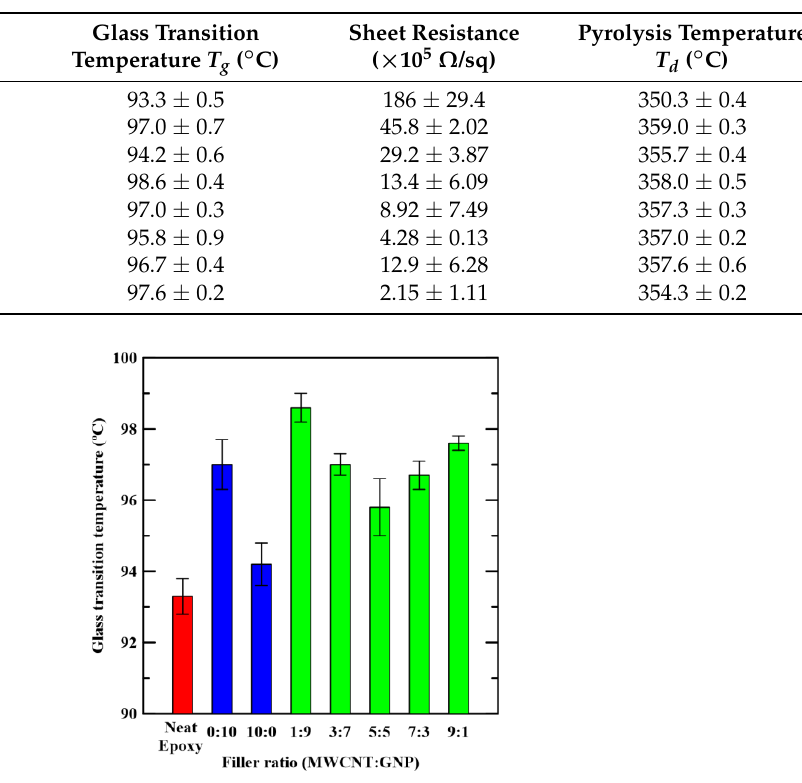
Table 1. Measured values of glass transition temperatures, sheet resistances, and pyrolysis temperatures for the epoxy composites with various MWCNT:GNP ratios.